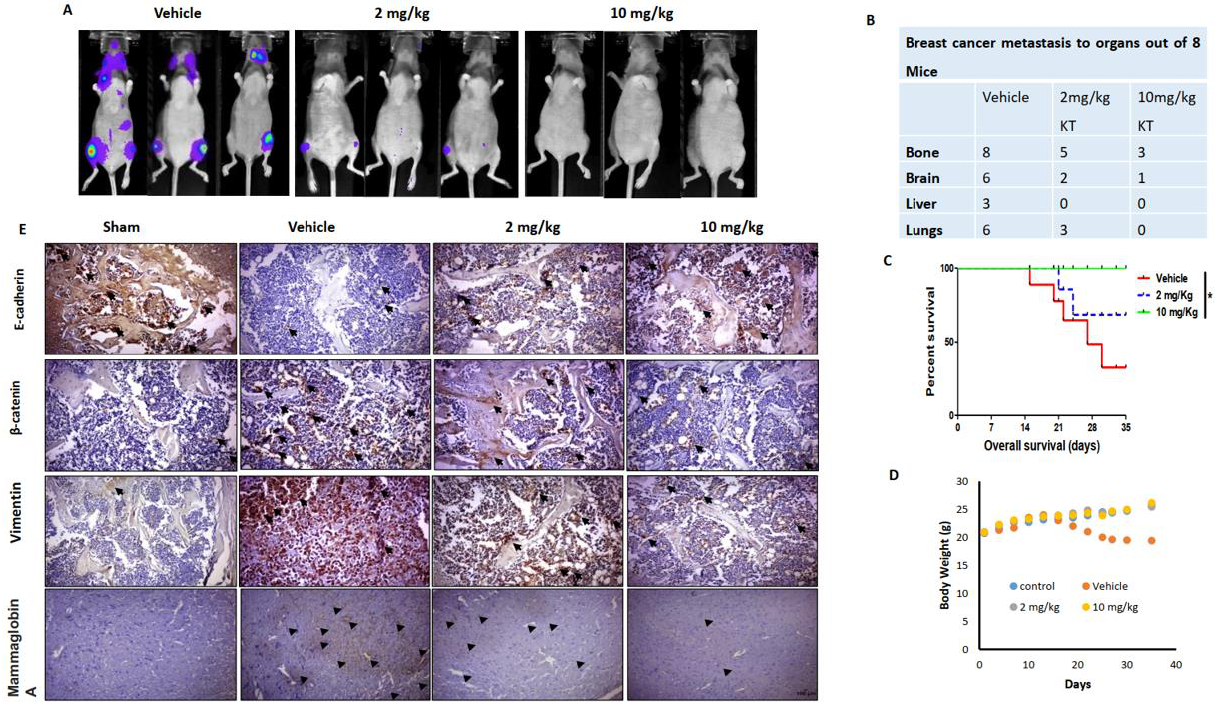
Figure 5. KT inhibits distant breast cancer metastasis in vivo. ( A ) MDA-MB-231 cells were intrac- ardially injected into the mice. After five weeks with or without treatment of KT, each group of mice had bioluminescence after five weeks. ( B ) Several distant metastases in mice of each group. ( C ) The Mantel-Cox log-rank test was used to determine percentage survival. ( D ) Average mouse weights during the course of the study were measured. ( E ) Femurs were fixed, decalcified, embedded, sectioned, and subjected to immunohistochemistry for EMT marker proteins such as E-cadherin, β -catenin, and vimentin in the femur section (Scale bar, 100 µ m). Arrow indicates the dense staining of the biomarker. Immunohistochemistry for mammaglobin A protein in the brain section was performed. Results are presented as means ± S.D. ( n = 8). * p < 0.05 indicates significant differences between KT-treated groups and